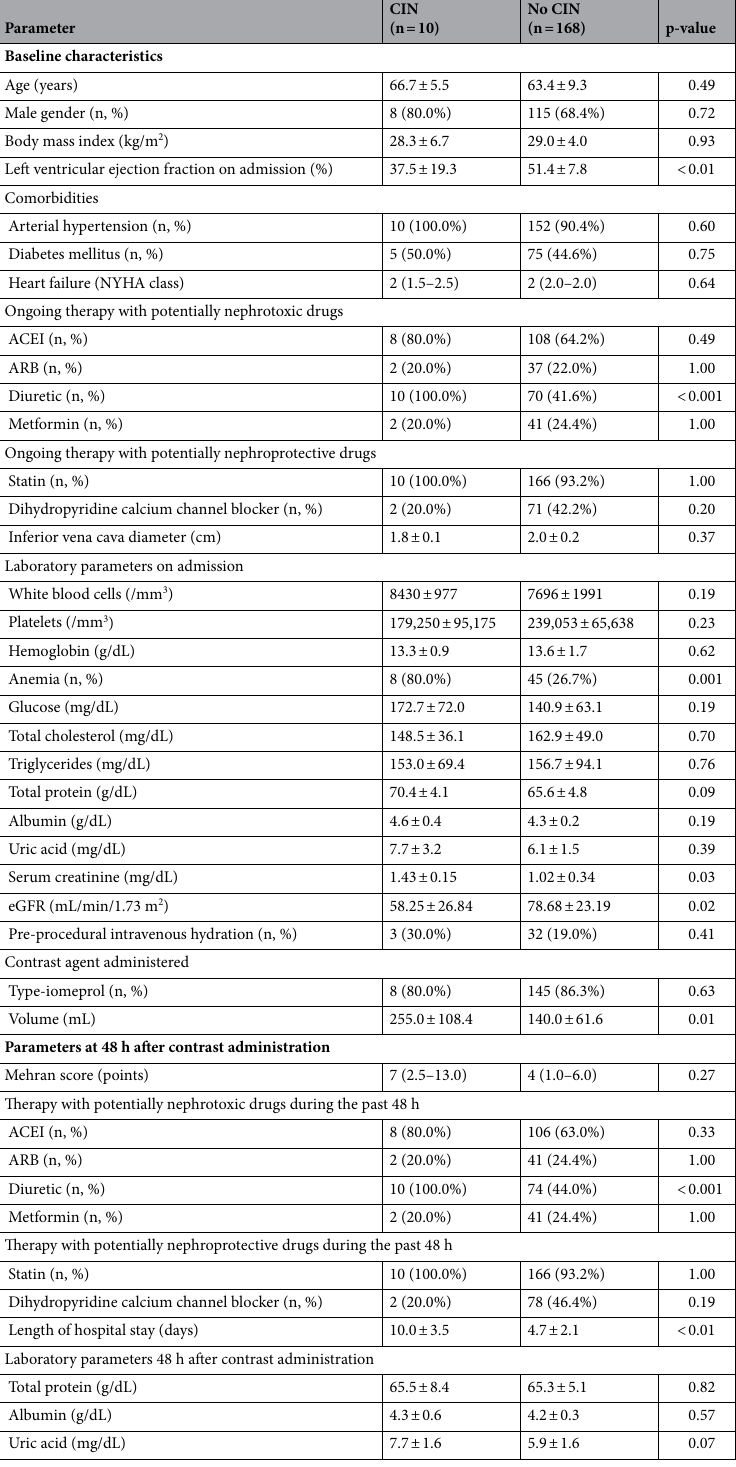
Table 2. Characteristics of patients who developed versus those who did not develop contrast-induced nephropathy. Contrast-induced nephropathy (CIN) was defined as an increase in serum creatinine by at least 25% 48 h following contrast administration vs . baseline. Anemia was considered present when hemoglobin was < 13 g/dL and/or the hematocrit was < 39% in males, and when hemoglobin was < 12 g/dL and/or the hematocrit was < 36% in females, respectively. Quantitative data are expressed as mean values ± standard deviation or median and interquartile range, as appropriate. Categorical data are expressed as number (percentage). p-values refer to comparisons between patients with and without CIN based on the unpaired t -test or the Mann–Whitney U test, as appropriate, for continuous variables, and Fisher’s exact test for categorical variables. ACEI angiotensin converting enzyme inhibitor, ARB angiotensin II receptor blocker, CIN contrast-induced nephropathy, eGFR estimated glomerular filtration rate, NYHA New York Heart